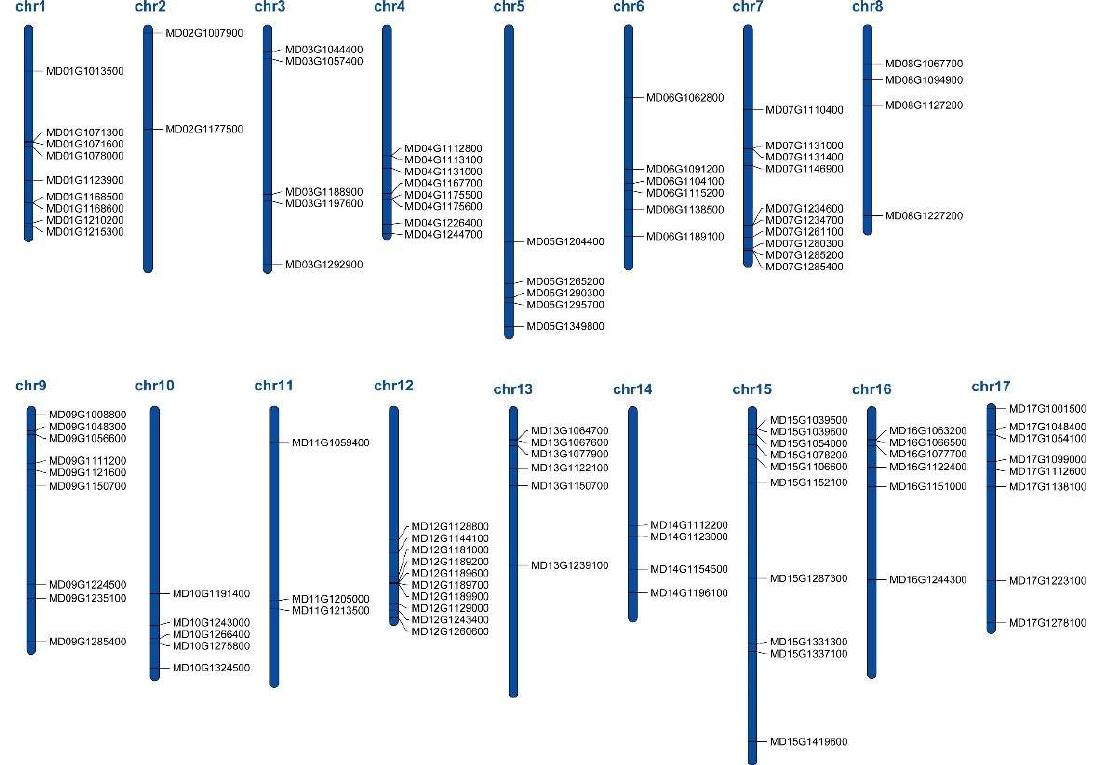
Figure 1. The distribution of WRKY genes on apple chromosomes. Chromosome number is indicated at the top of each chromosome.